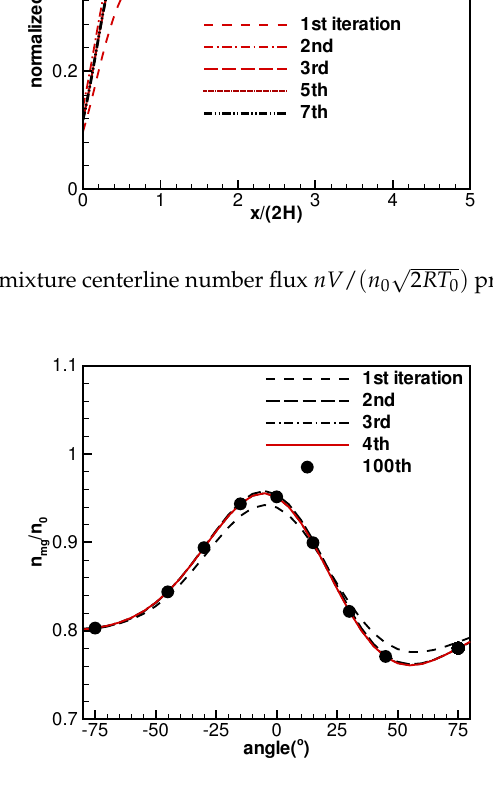
Figure 18. Test case: mixture density profile development history, along R = 3 m.